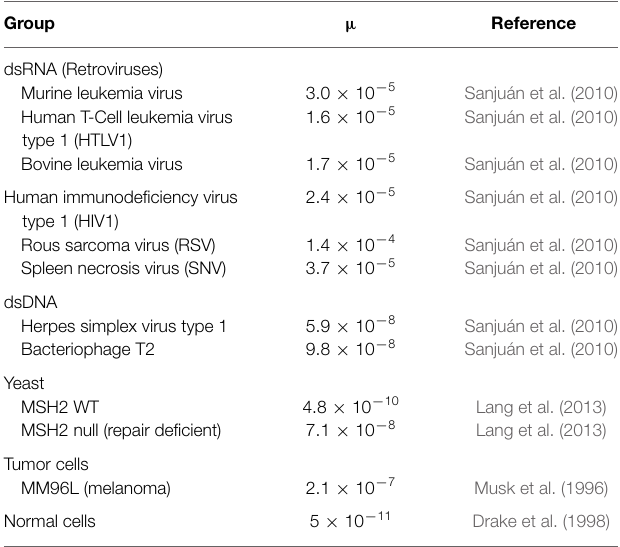
TABLE 2 | Mutation rates expressed as substitutions per nucleotide per cell infection (in viruses) and mutations per cell division (in eukaryotes—yeast, tumor and normal